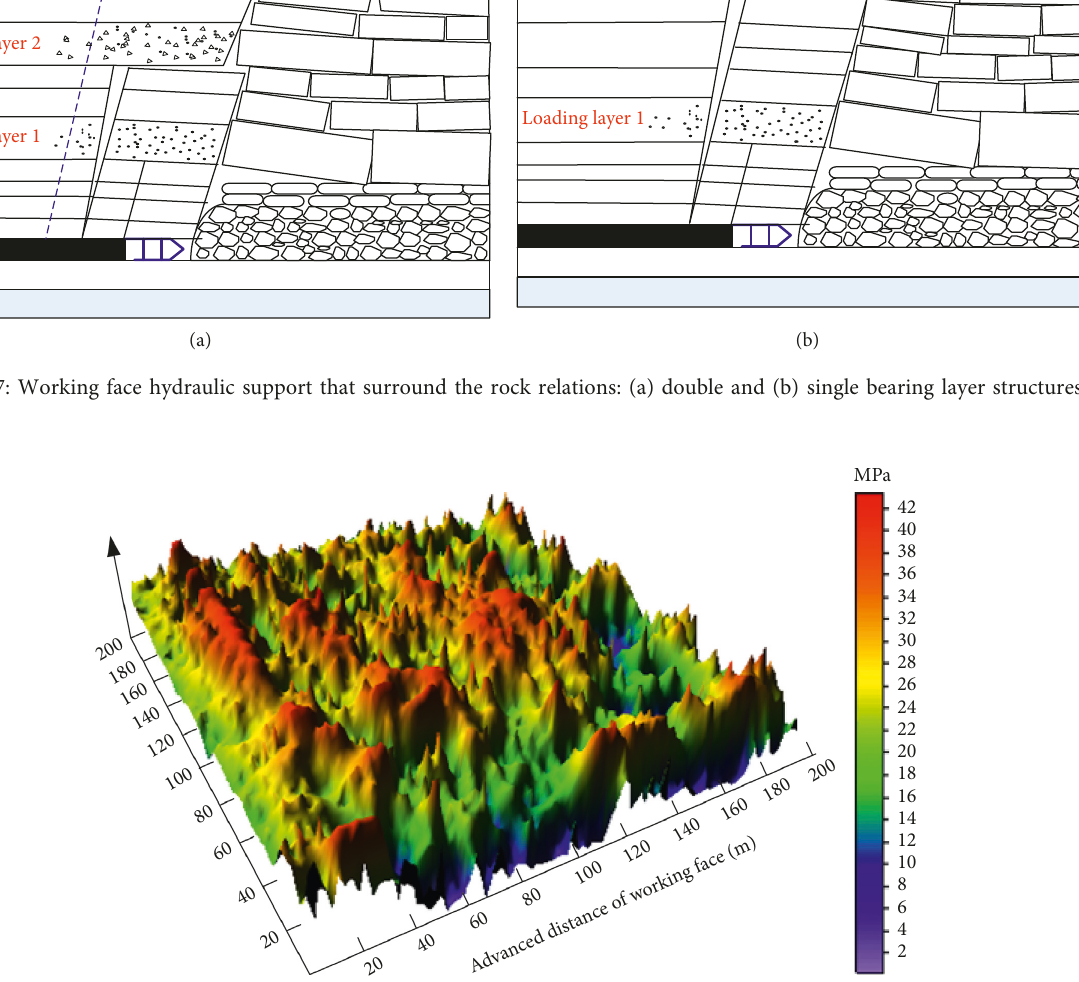
Figure 8: Face hydraulic support working resistance contour map.